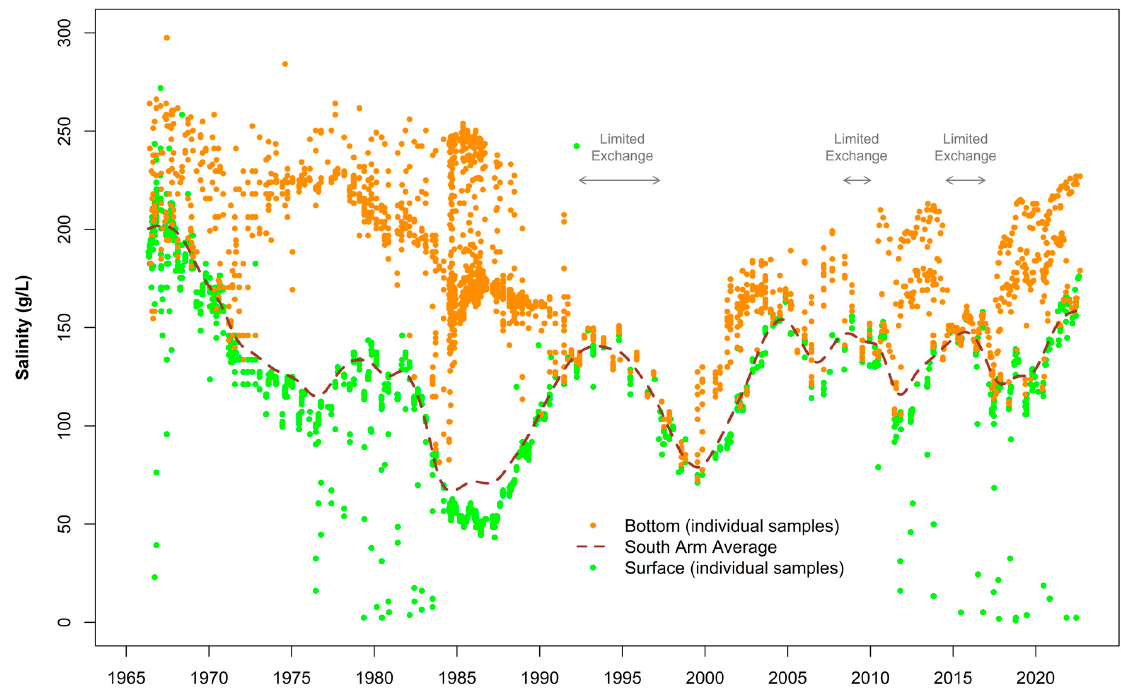
Figure 9. Salinities in the south arm. Surface (less than 0.3 m depth) and bottom (below 1272.5 m elevation) salinity points were calculated using individual measurements from sample sites within the 1272.5 m contour shown in Figure 1 (including UGS sites RT4, RT2, RT1, NLN, FB2, AS2, AC3, and AC2; and USGS sites 405356112205601, 410637,112270401, and 410644112382601). The